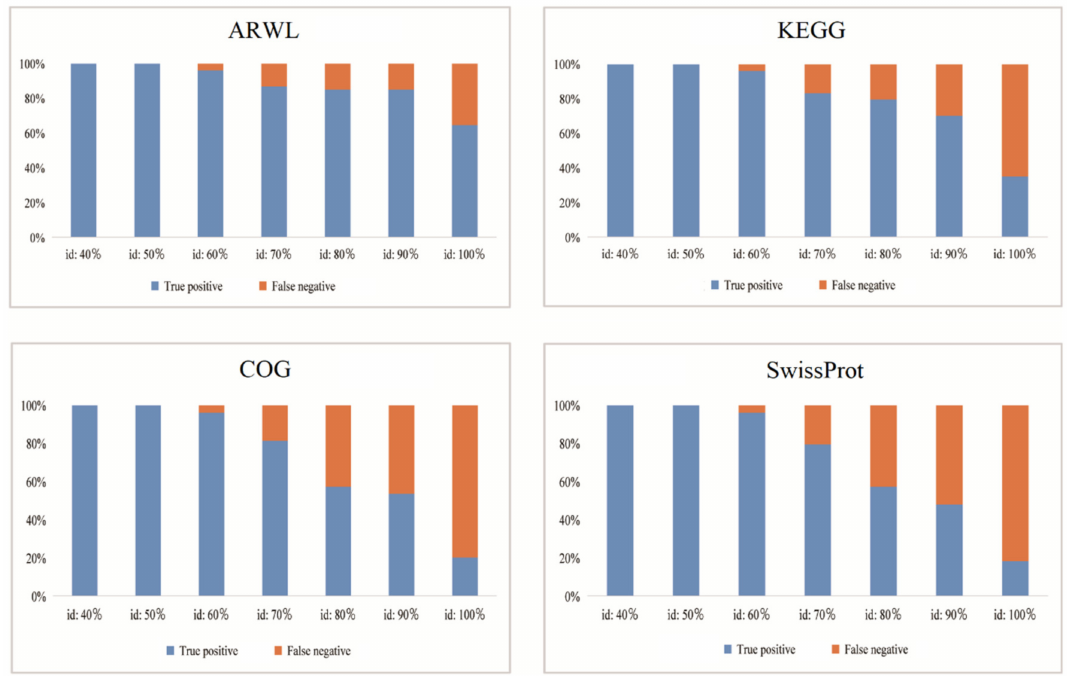
Figure 5. Accuracy assessment of the ARWL, KEGG, COG and SwissProt